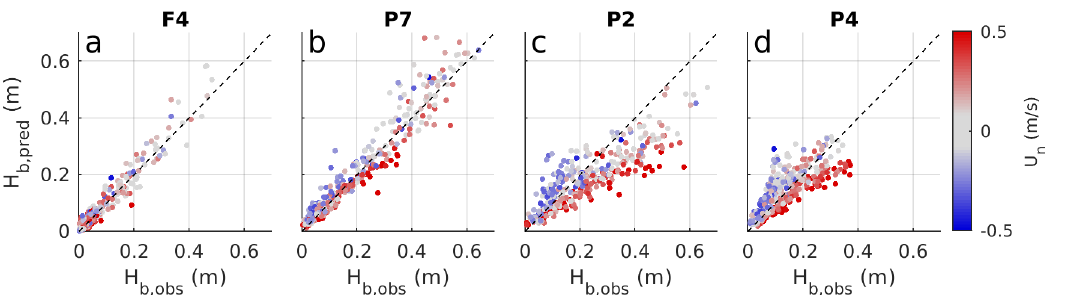
Figure 8. H b , pred as a function of H b , obs at F4 ( a ), P7 ( b ), P2 ( c ), and P4 ( d ) where the color indicates the current in direction of wave propagation U n (blue = opposing currents, red = following currents).